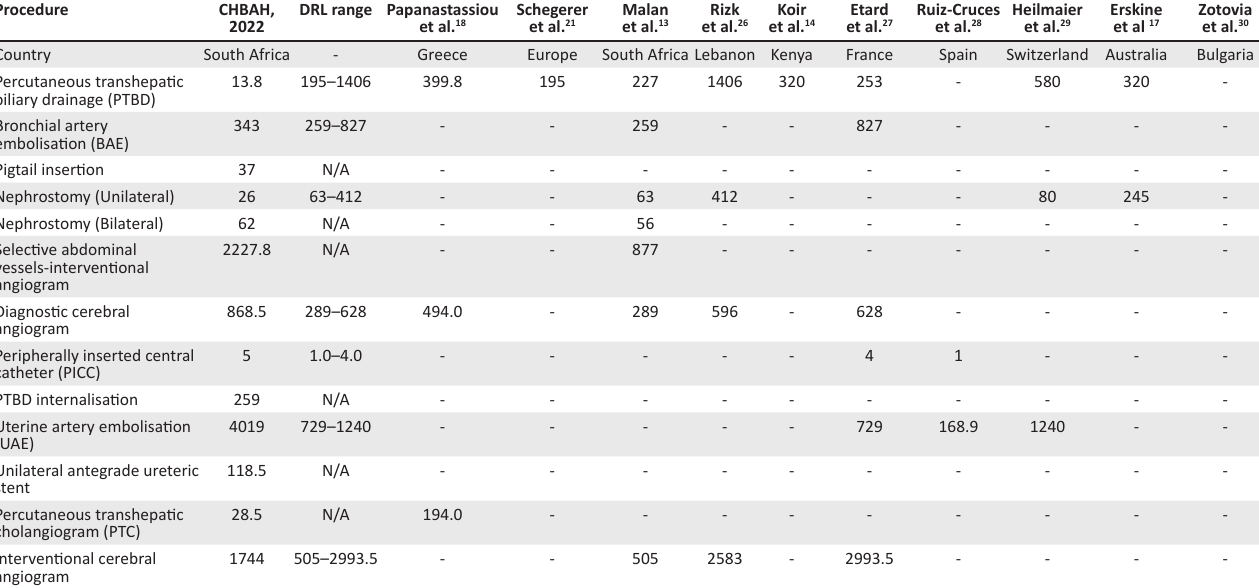
TABLE 2b: Comparison with published data on reference point air kerma and diagnostic reference